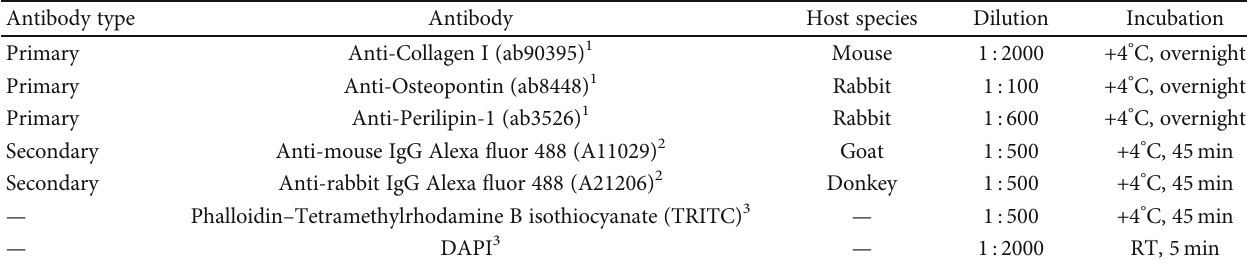
Table 1: Reagents used in cytochemical staining.